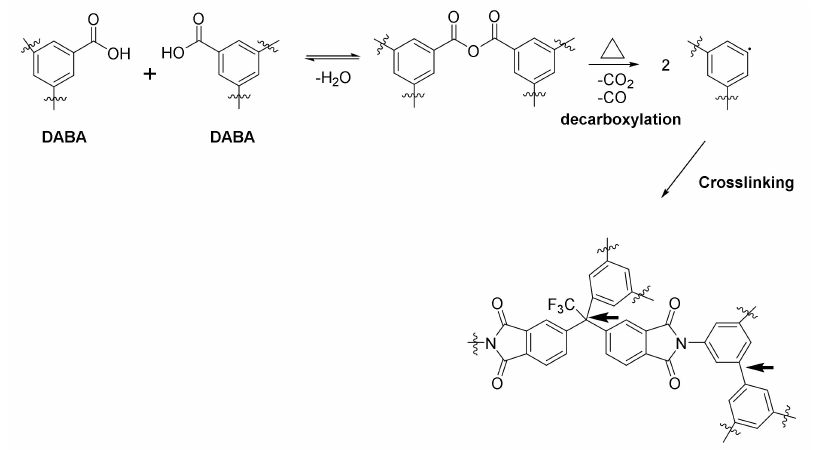
Figure 10. Crosslinking mechanism for copolymers incorporating DABA monomer and CF 3 groups [53] (bold arrows represent the plausible crosslinking points).